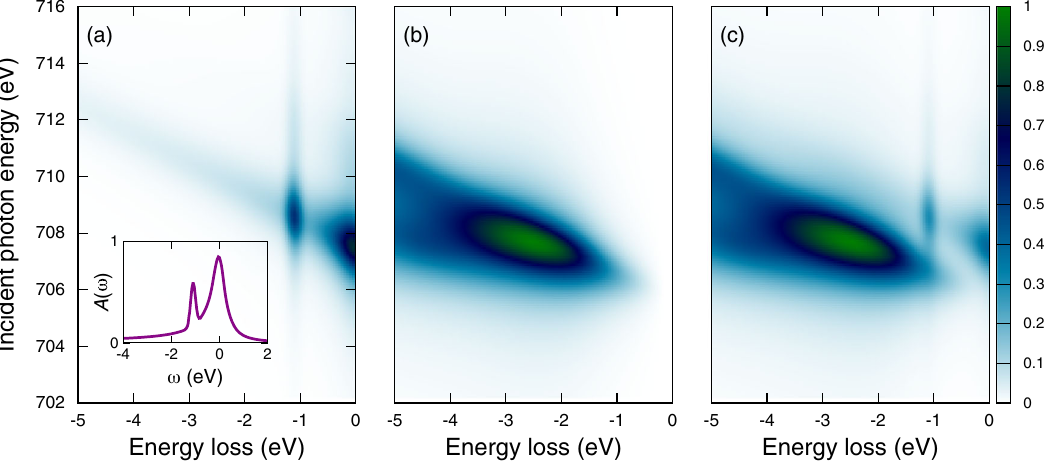
FIG. 11. Calculated RIXS maps for BaFe 2 As 2 using the model spectral function shown in the inset in (a) in conjunction with the approximations made in Eqs. (13) and (14). The panels show the indirect contribution (a), direct contribution (b), and the full RIXS signal (c). The intensity of the indirect contribution in (a) is multiplied by 2 for visual clarity. The model spectral function consists of a Doniach-Sunjic profile with the addition of a satellite peak at 1.1 eV representing a local dd